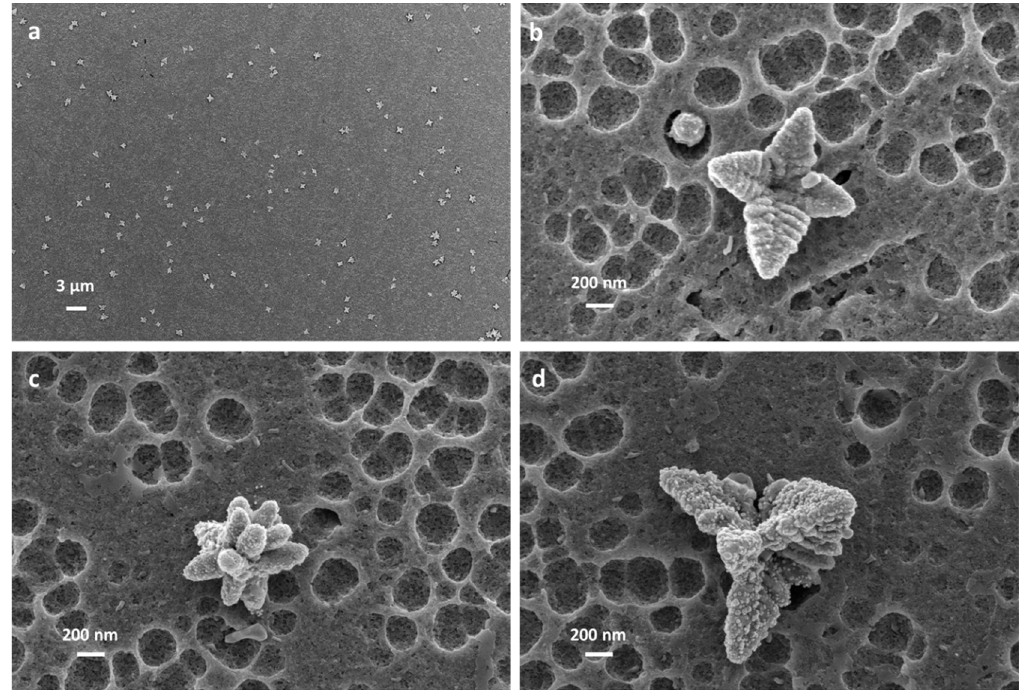
Figure 3. FE-SEM observations of CEL2 + pad (1 mg/mL) + Ag. ( a ) Low magnification overview of surface; ( b – d ) Ag precipitates as dendrimeric nanoflowers and holes on the glass surface due to reaction in the functionalization media (higher magnification).